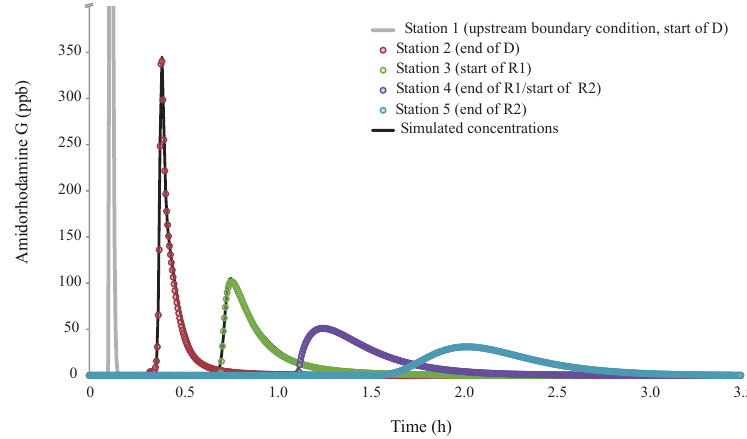
Figure 3. Tracer breakthrough curves for the conservative tracer addition experiment in the river Ruhr. Upstream boundary condition based on concentrations at sampling station 1 (start of degraded reach, D, grey solid line), observed concentrations at sampling stations 2 (end of degraded reach, empty circles), 3 (start of first restored reach, R1, empty squares), 4 (end of first restored reach, start of second restored reach, R2, empty triangles), 5 (end of second restored reach, crosses), and simulated concentrations based on final parameter estimates with OTIS-P (solid